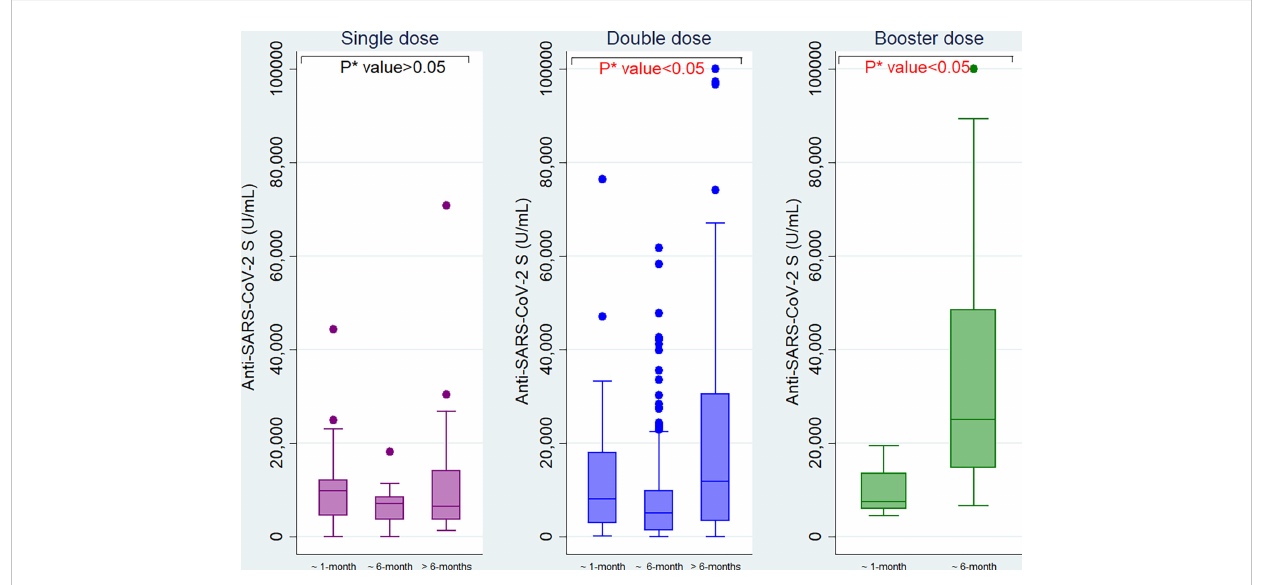
FIGURE 5 Anti − SARS − CoV − 2 S antibody titers among the migrant workers at different time intervals since last vaccination. *P value is generated by Kruskal Wallis